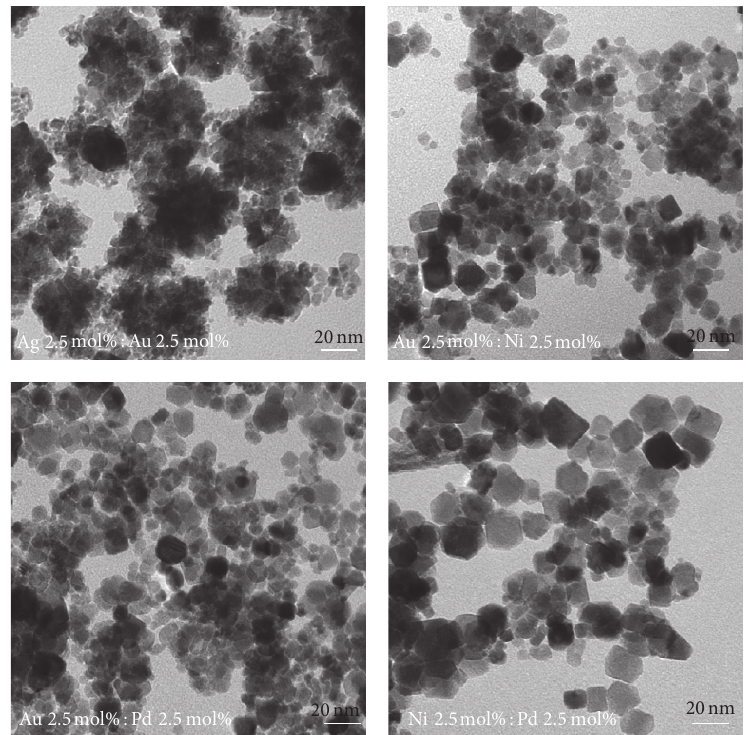
Figure 1: Typical TEM image of Au/Ag, Au/Ni, Au/Pd, and Ni/Pd codoped (2.5 and 2.5 mol.%, resp.) CeO 2 catalysts.